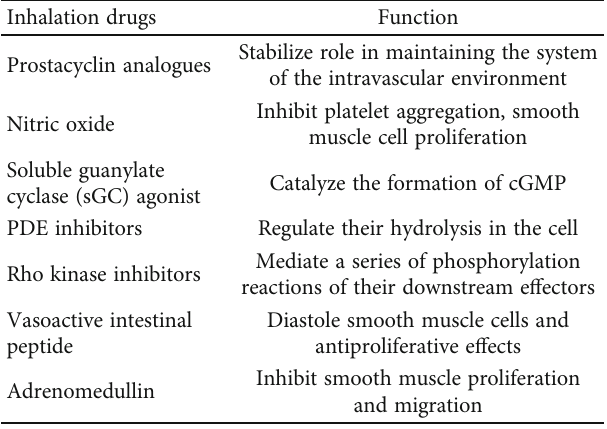
Table 1: The inhalation drugs and their function to treat